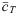
The average period of oscillations at different values of the average calcium concentration c¯T, for a concentration of CSQ of BSQ = 2mM (green dots), and in the absence of CSQ (blue dots).